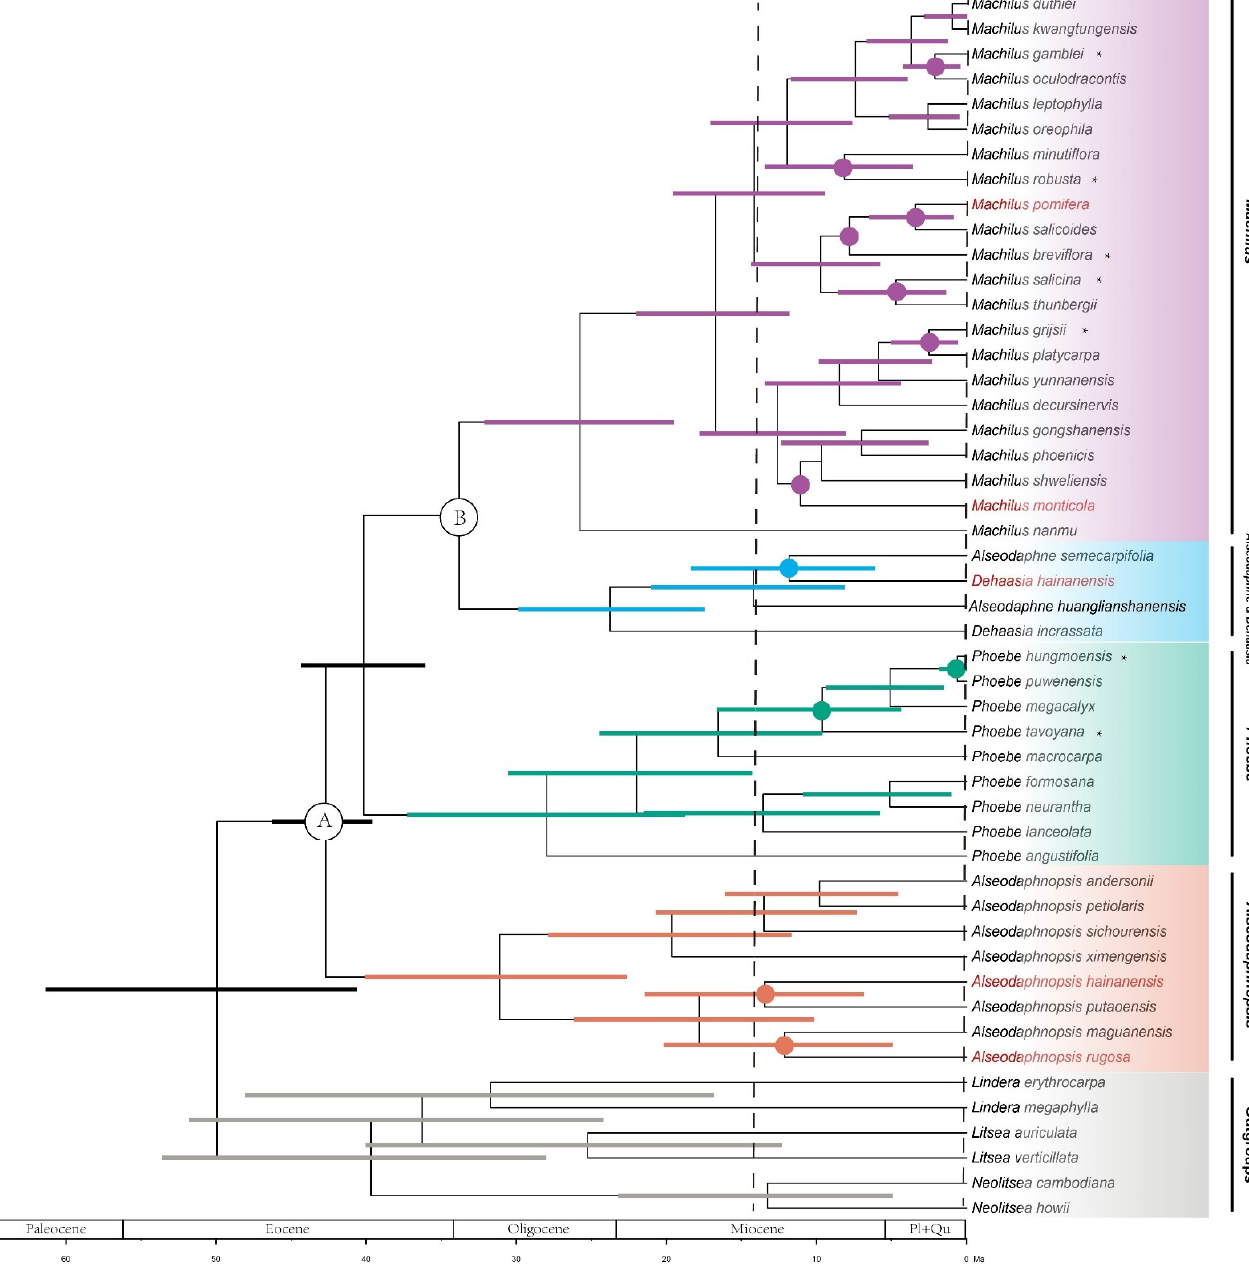
Figure 2. Time tree of the Persea group on Hainan based on nrITS and LEAFY intron II inferring from BEAST analysis. Letters in empty circles indicate fossil calibrations; species with asterisk (*) means occurring on Hainan; Hainan Island endemic species are highlighted in red; black bars show 95% con- fidence